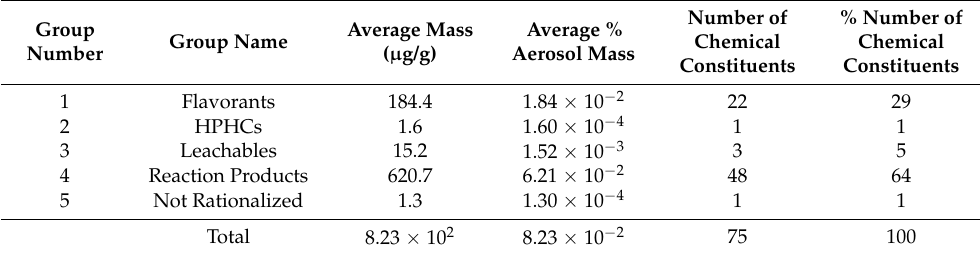
Table 8. Summary of non-targeted analyses in Me5 aerosol detected by GC and LC NTA methods using the non-intense puffing